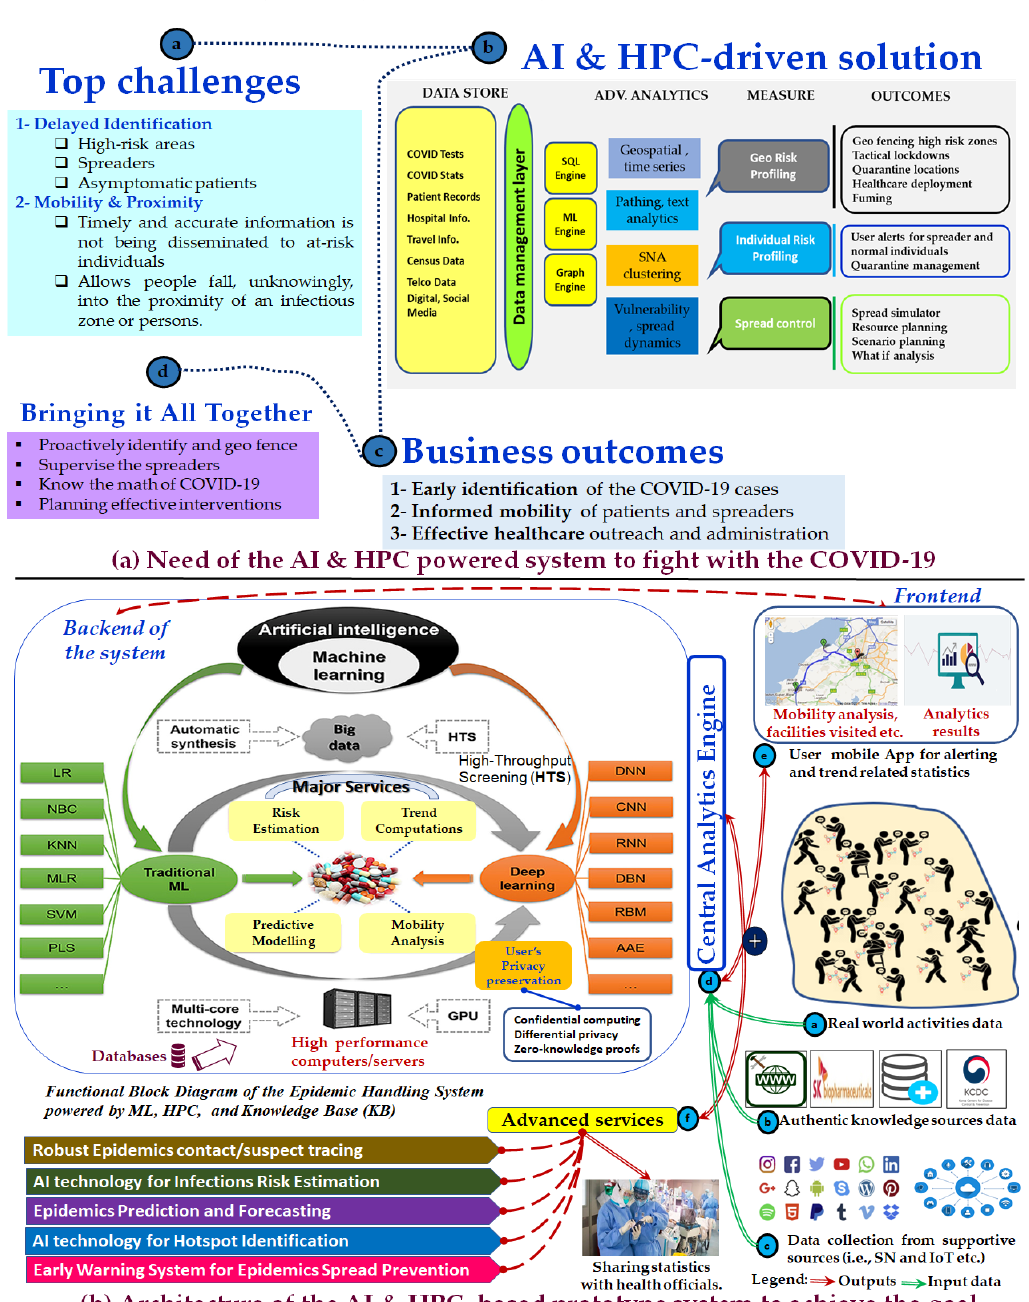
Figure 7. ( a ) Need for an ML- and HPC-based system in the era of COVID-19 and ( b ) architecture of the ML- and HPC-based prototype system to fight with the